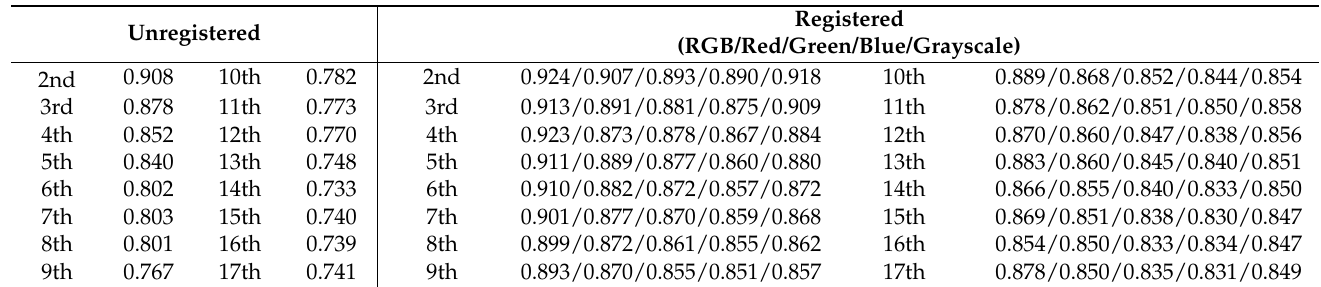
Figure 5. Registered time sequence image samples. Images in the top and bottom rows demonstrate consecutive images in a time sequence. The 1st image on the left of each row is the fixed one, which is the 1st image in the sequence, and each image toward the right side in each row demonstrates the 6th, 12th, and 17th registered sample in that time sequence. Table 3. Average Dice scores of each pair of fixed and succeeding images in the unregistered time sequence (left section) and the registered time sequence (right section). The numbers 2nd, 3rd, 4th, . . . , 17th denote the Dice scores calculated between the prediction mask on the nth image and the 1st image in that time sequence; see the line plot in Figure